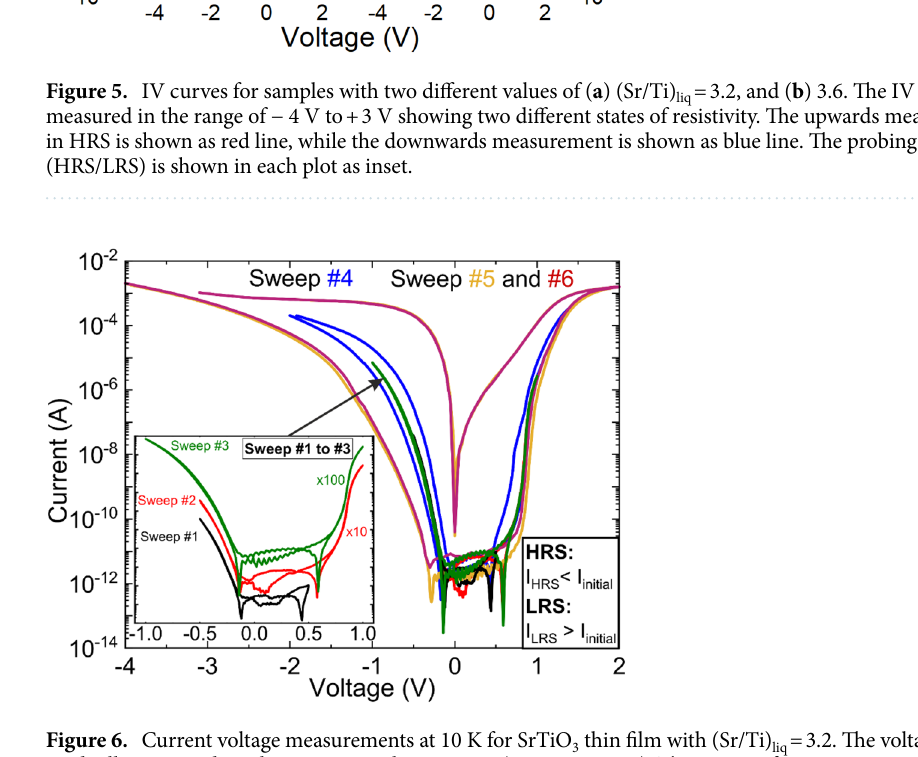
Figure 6. Current voltage measurements at 10 K for SrTiO 3 thin film with (Sr/Ti) liq = 3.2. The voltage range was gradually increased until resistive switching occurs (Sweep #1 to #6). The curves of sweep #1 to #3 are shown vertically shifted to each other by a factor of 10 in the inset. (Partial) switching occurs for V > 1.5